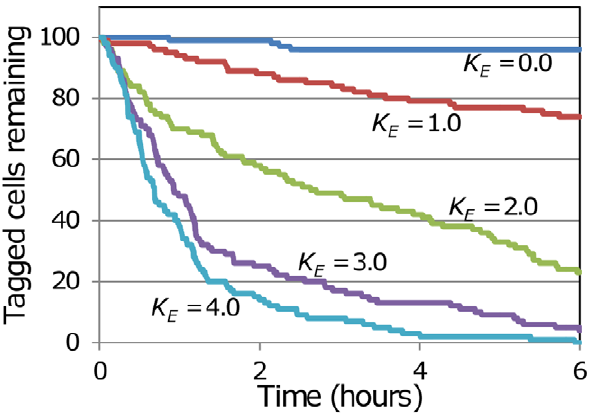
Figure 5. Cell retention with varying levels of egress chemo- taxis. To explore the influence of chemotaxis in a simplified setting, simulations of steady-state trafficking were carried out for a blob of 10 k cells with a single exit portal at the centre. All cells were non- chemotactic, except for 100 tagged cells initially at randomly-selected locations within a sphere of radius=7 grids centred on the exit portal. The trajectories of these chemotactic cells were recorded over six hours of simulation. For five simulation runs with a range of values of the chemotaxis parameter K E , the number of tagged chemotactic cells remaining in the blob has been plotted as a function of time.